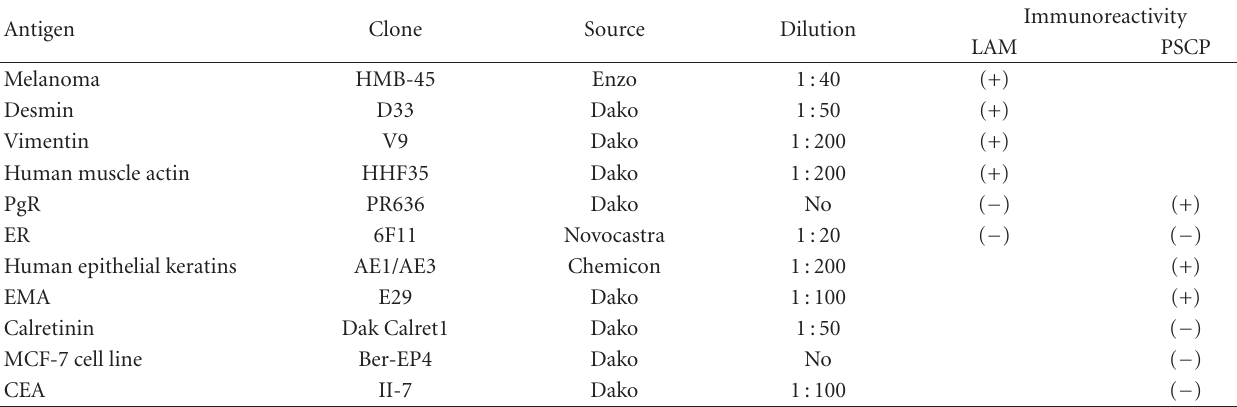
Table 1: Summary of immunohistochemical stains in lymphangioleiomyomatosis (LAM) and papillary serous carcinoma of the peritoneum